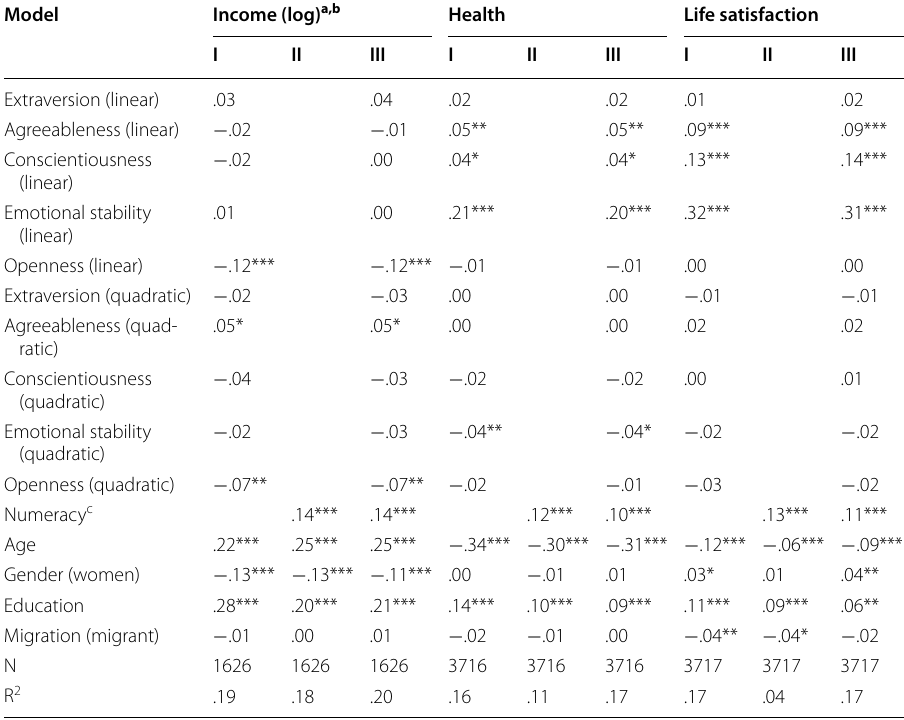
Table 3 Relationships between personality, numeracy, and important life